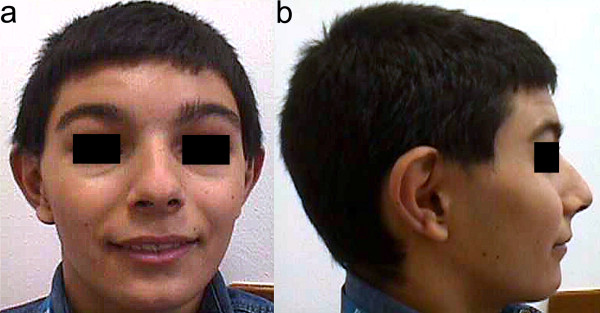
Frontal (a) and lateral (b) view of a KBG patient with typical facial dysmorphisms including low frontal hairline, wide eyebrows with mild synophrys, hypertelorism, prominent and high nasal bridge, anteverted nostrils, long philtrum, thin upper lip and prominent anteverted ears. Macrodontia of upper central incisors is observable.